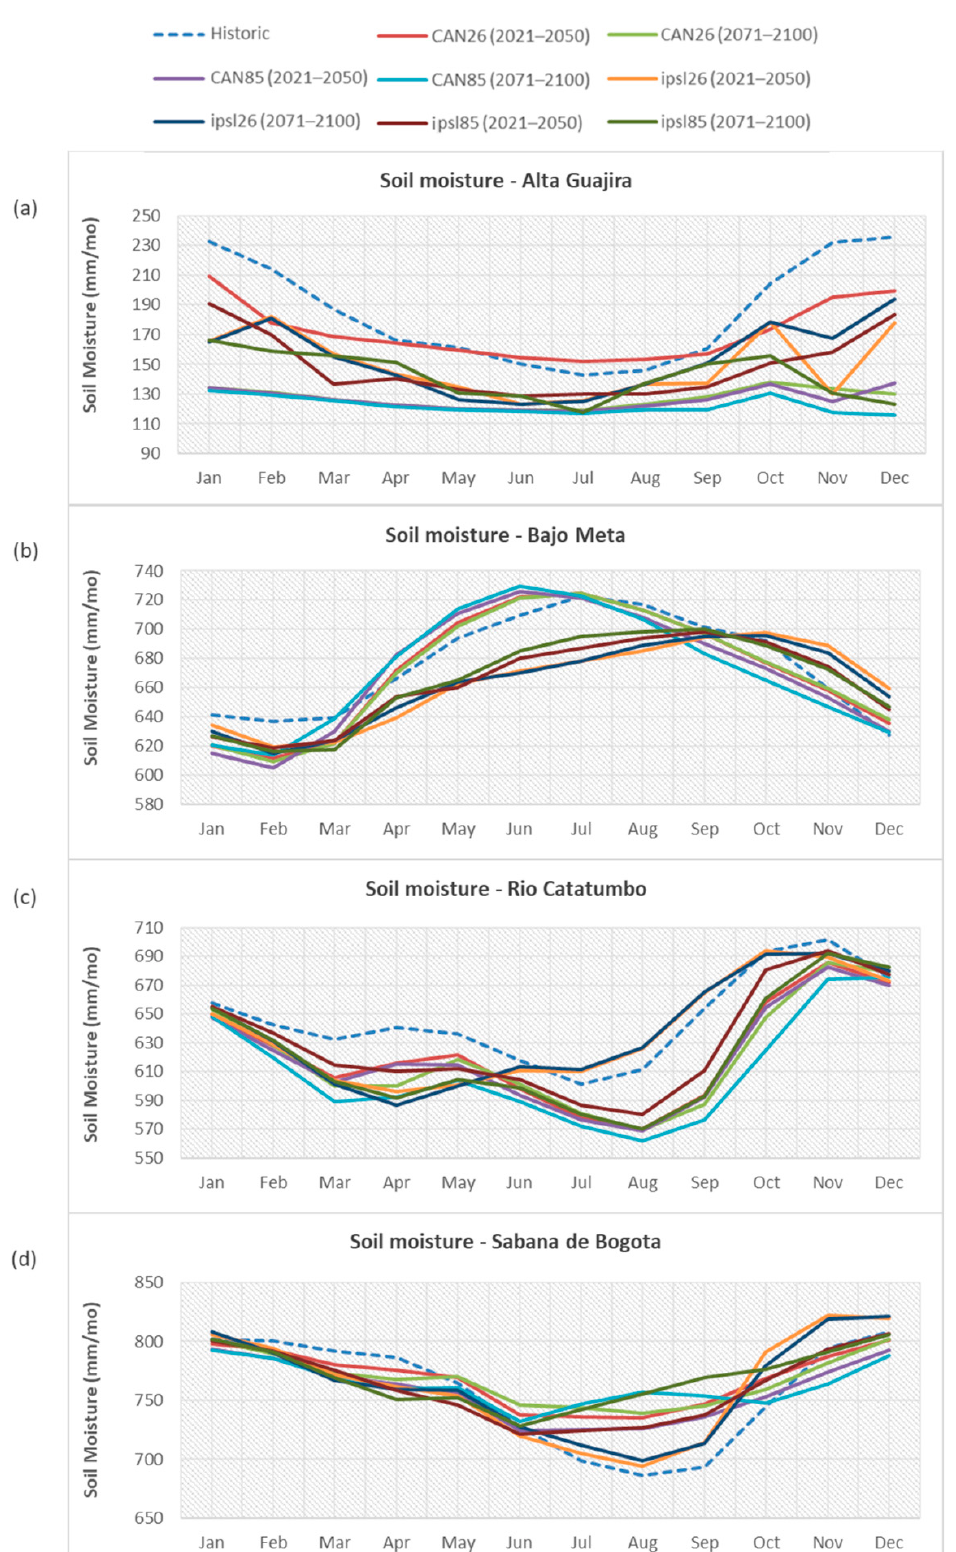
Figure 2. Monthly averaged soil moisture in (a)Alta Guajira; (b)Bajo Meta; (c)Rio Catatumbo; (d)